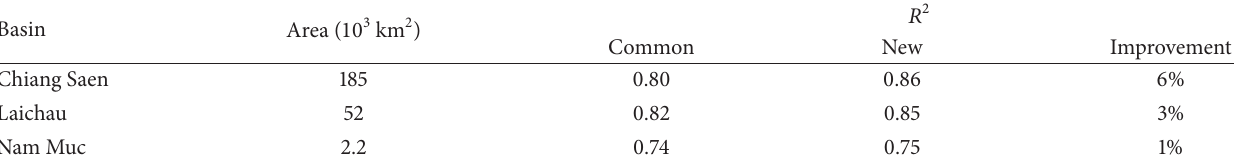
Table 7: Summary of improvement compared with common rating curve in three